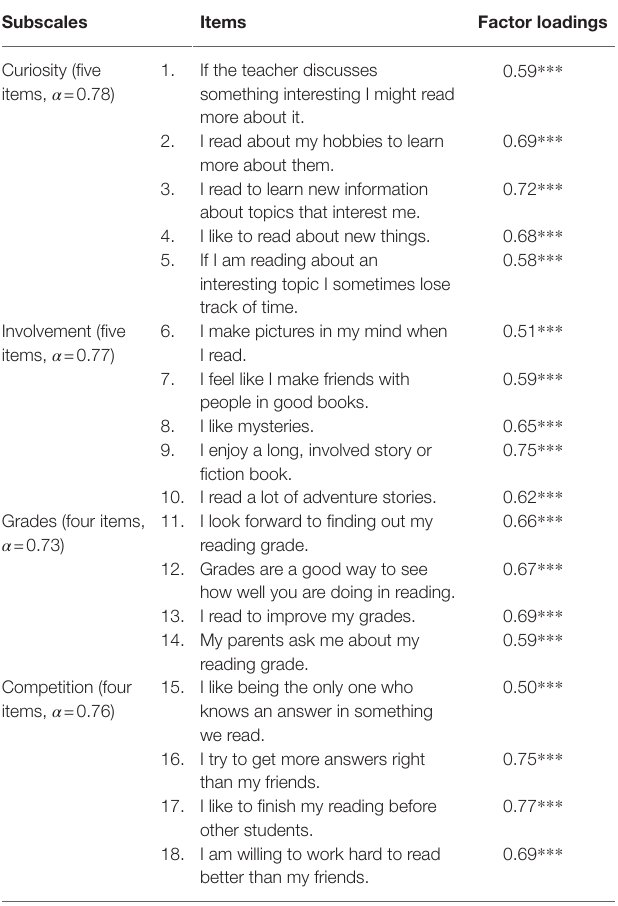
TABLE 1 | The adapted version of Motivation for Reading